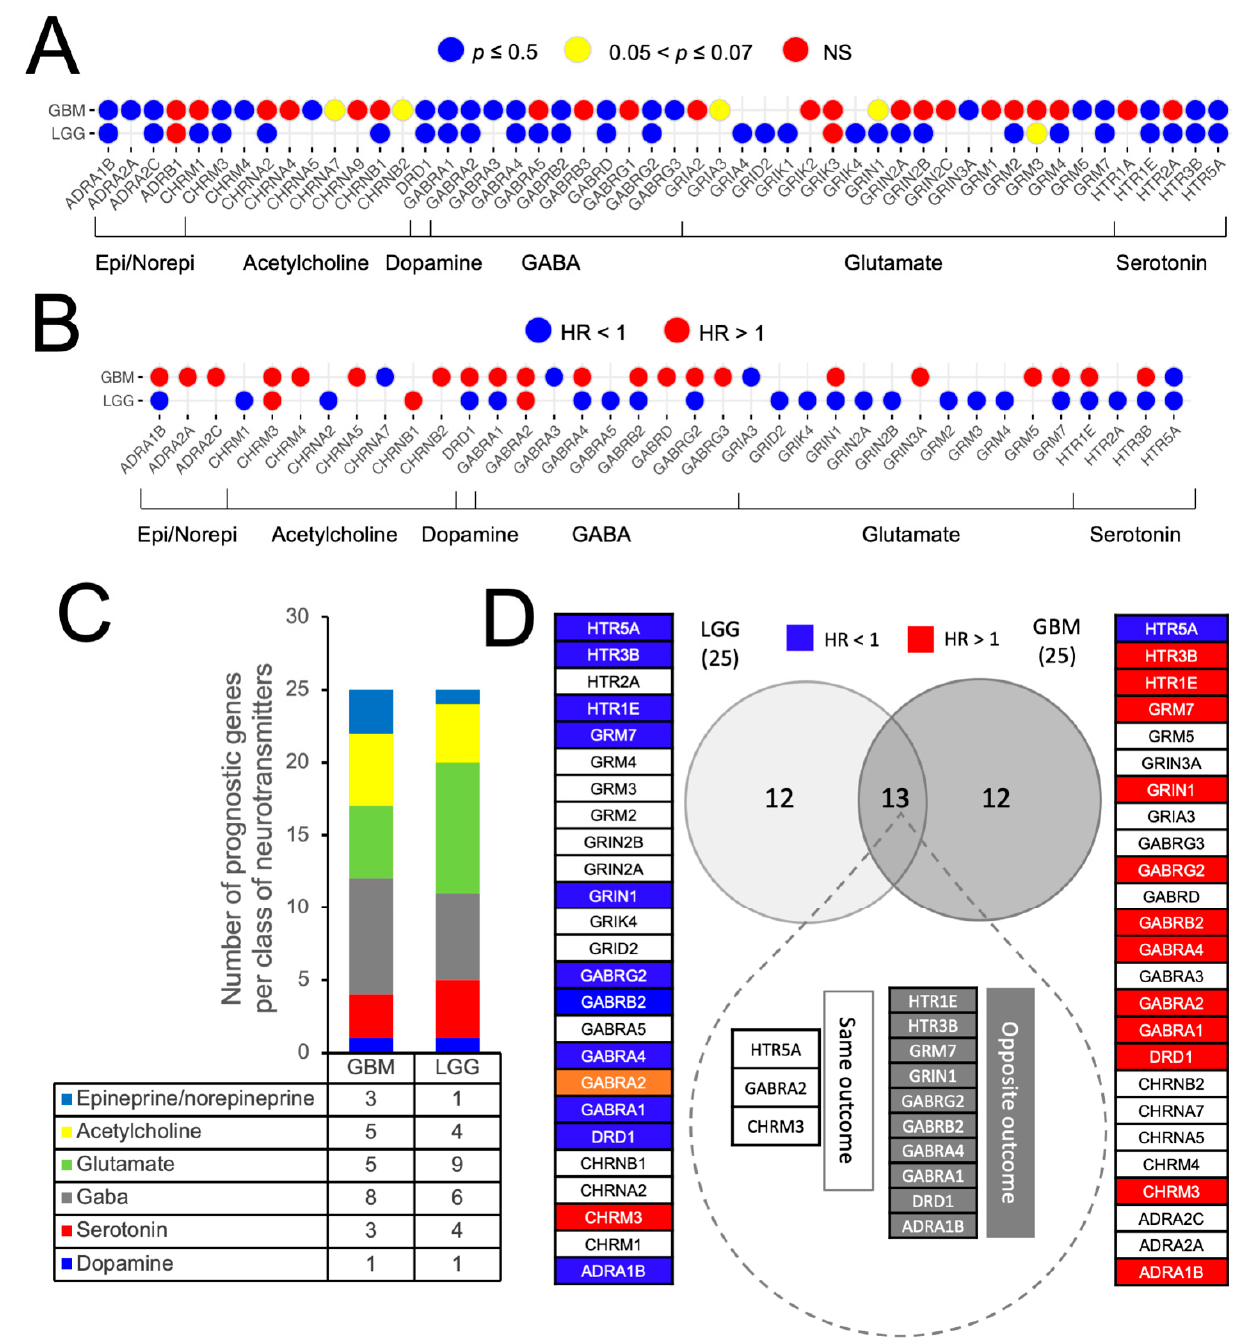
Figure 3. Impact of NTR genes on patient survival. ( A ) The color of the dots represents three different outcomes of the p -value of the log-rank test of each of the differentially expressed genes (DEGs) shown in Figure 2. On the x-axis, the gene symbols are shown, while the y-axis reports the symbols of the cancer types. The non-significant (NS) cases did not achieve statistical significance. ( B ) The color of the dots represents the value of the hazard ratio (HR) resulting from the application of the Cox model to each of the genes that reached statistical significance at the log-rank test in ( A ). The NTR genes associated with “negative prognosis” are in red, and the genes associated with “positive prognosis” are in blue. All the NTR genes that exhibited a p ≤ 0.05 at the scaled Schoenfeld residuals (Supplementary Table S2) test were excluded from the analysis. ( C ) Distribution of negative and positive DE prognostic NTR genes across the two cancer types, for each class of neurotransmitters. ( D ) Prognostic NTR genes shared by LGG and GBM and their impact on overall